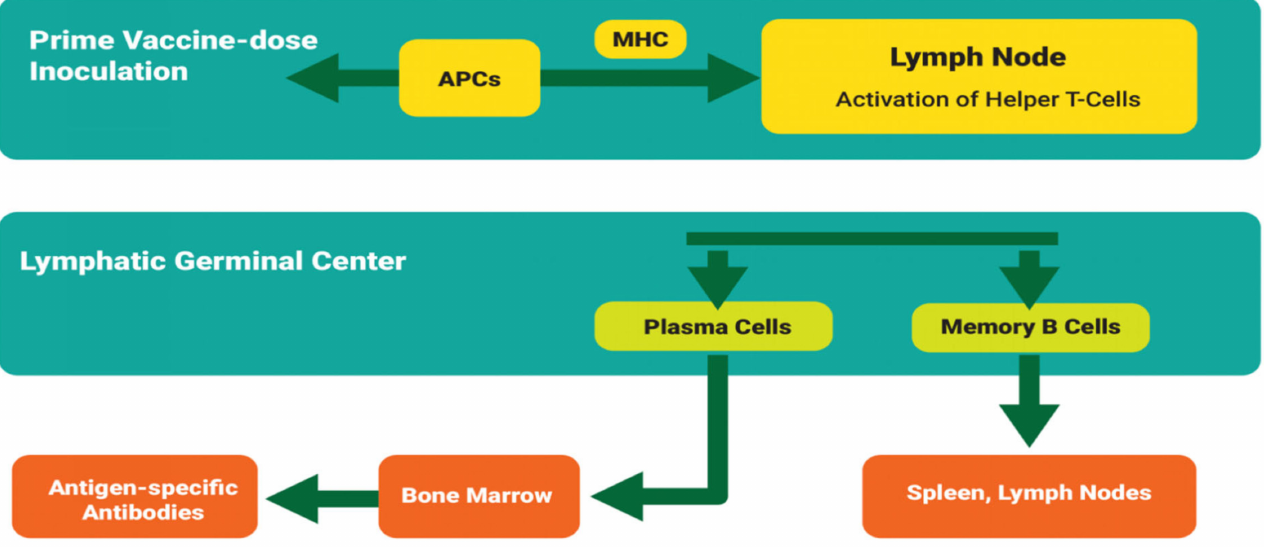
Figure 2. A schematic illustration of hypothetical mechanism of anti-tick immune-memory induction. Abbreviations: MHC (major histocompatibility complex). APCs (antigen presenting